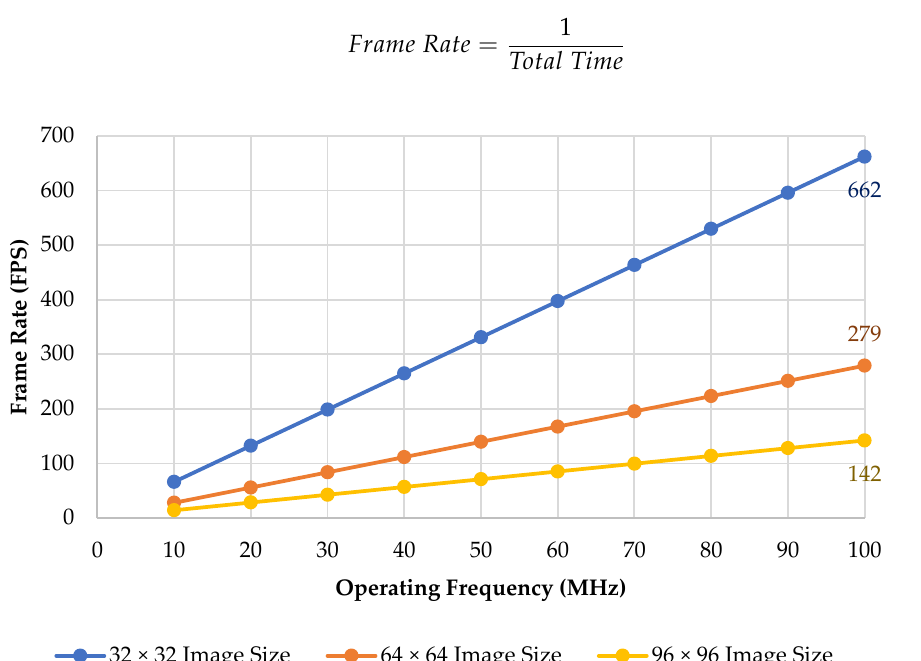
Figure 7. The frame rate across the different operating frequencies.